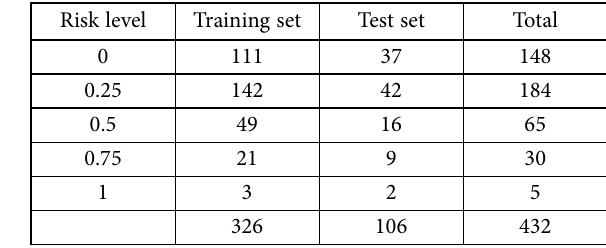
Table 12. Training set and test set sample distribution